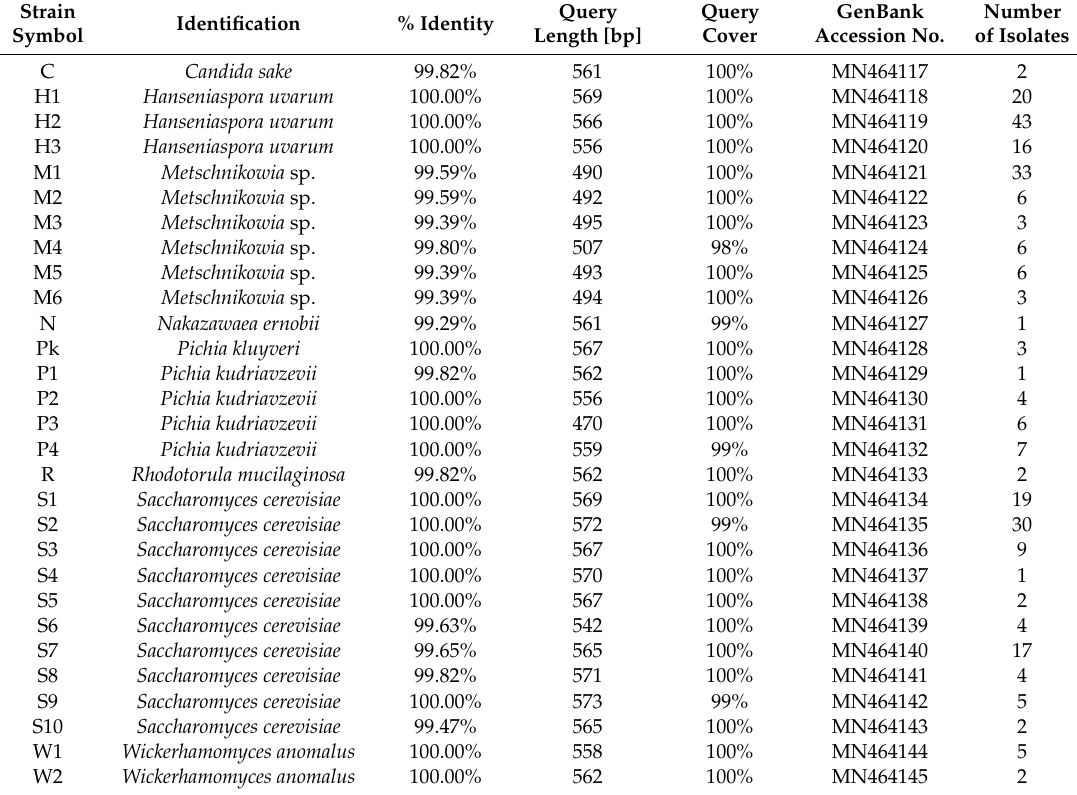
Table 1. Yeast identification by the 26S rRNA D1 / D2 domains